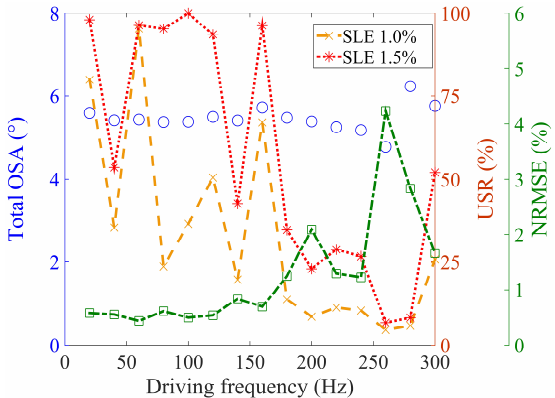
Figure 11. Experimental performance of the proposed input shaping with respect to driving frequency (driving voltage: 25 V, sampling rate: 50 kHz): total OSA with respect to driving frequency (circles in blue), usable scan range (dashed lines), and NRMSE (dash–dot line in green). The NRMSE values remain below 1% for frequencies up to 160 Hz, which corresponds to the C-linear region for a scan angle of 5.6° or smaller. The NRMSE values abruptly degrade beyond the C-linear region.